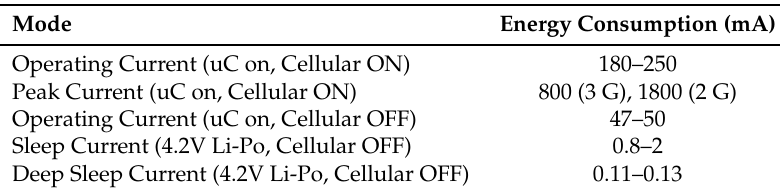
Table 4. Particle electron energy consumption.